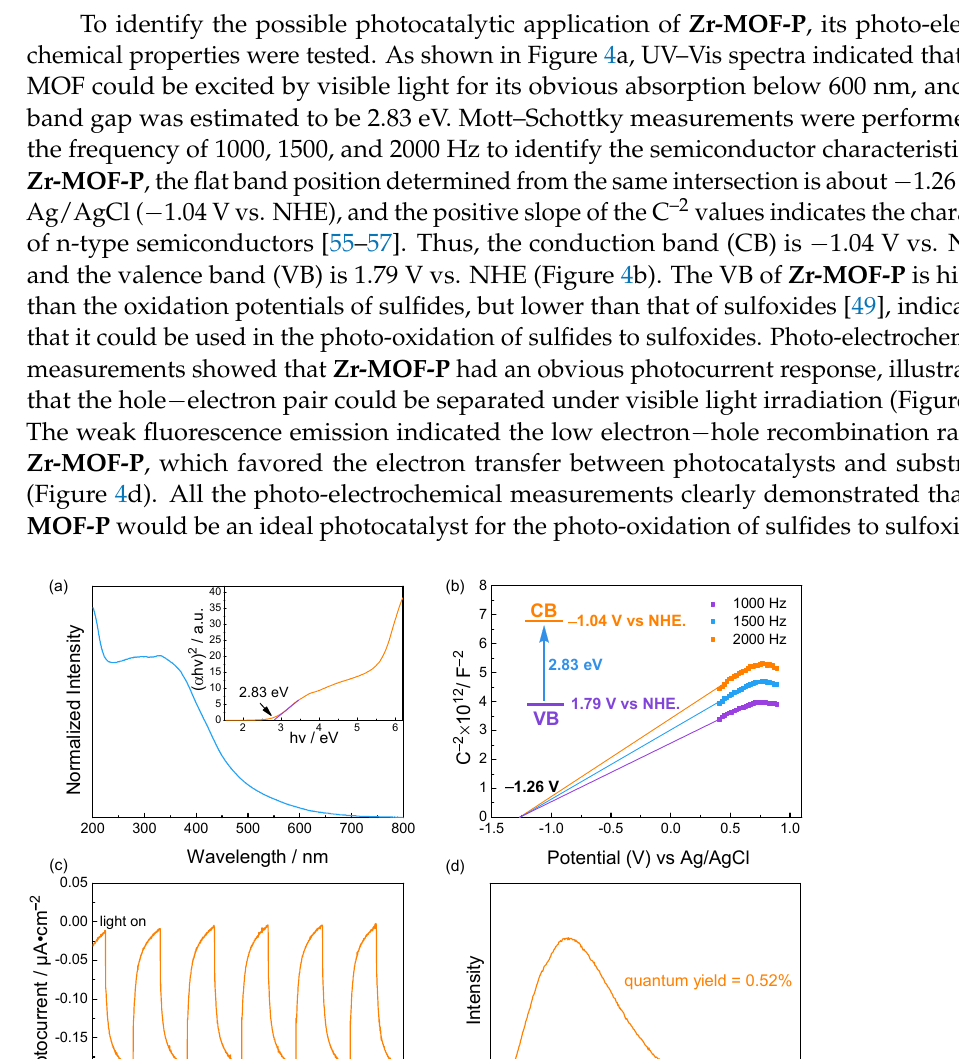
Figure 3. ( a ) Structure of Zr-MOF-P . C, gray; O, red; P, pink; Zr, cyan polyhedra; the yellow sphere is the cavity; H atoms are omitted for clarity. ( b ) The flu topology of Zr-MOF-P . The orange and cyan polyhedra represent 4- and 8-connected nodes, respectively.